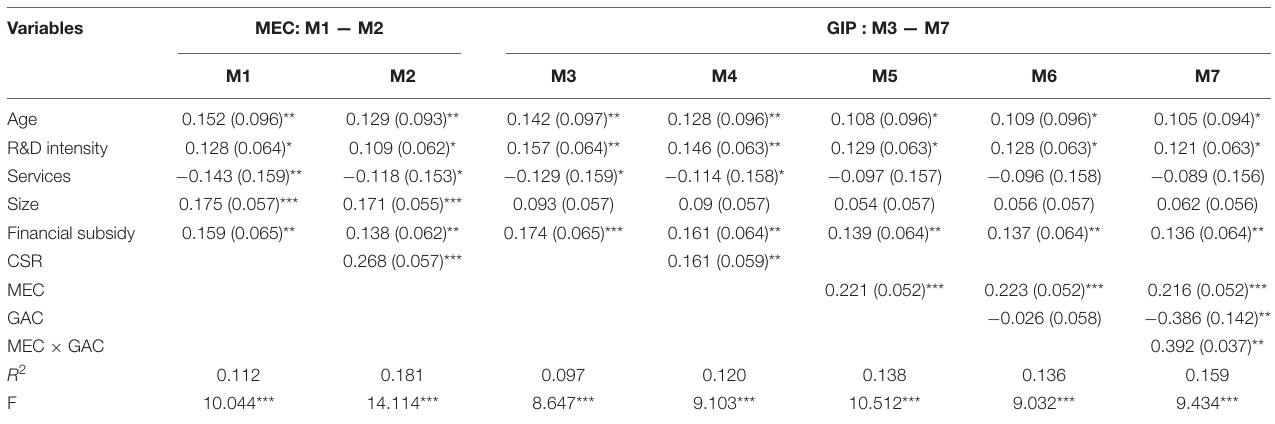
TABLE 5 | Regression analysis